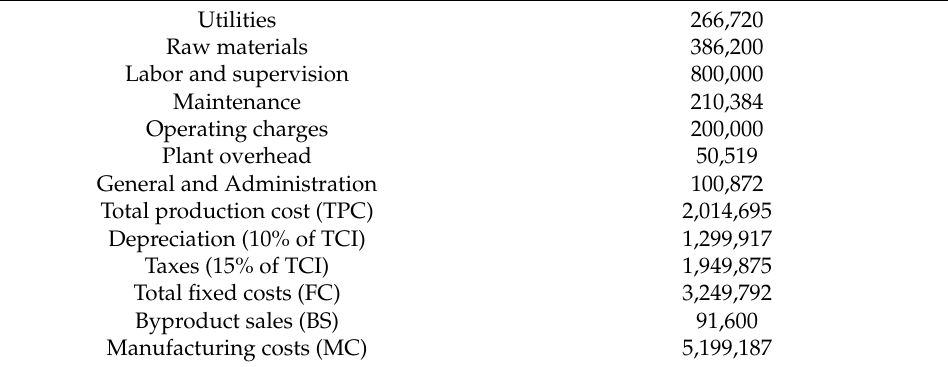
Table 12. Total production and fixed costs of biodiesel expressed in